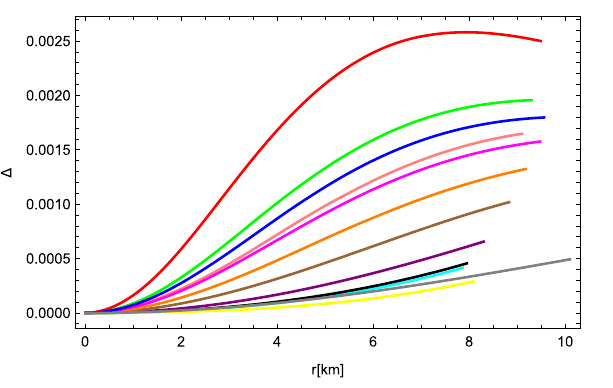
Fig. 6 Behavior of F h , F g and F a of S 1 ( (cid:2) ), S 2 ( (cid:2) ), S 3 ( (cid:2) ), S 4 ( (cid:2) ), S